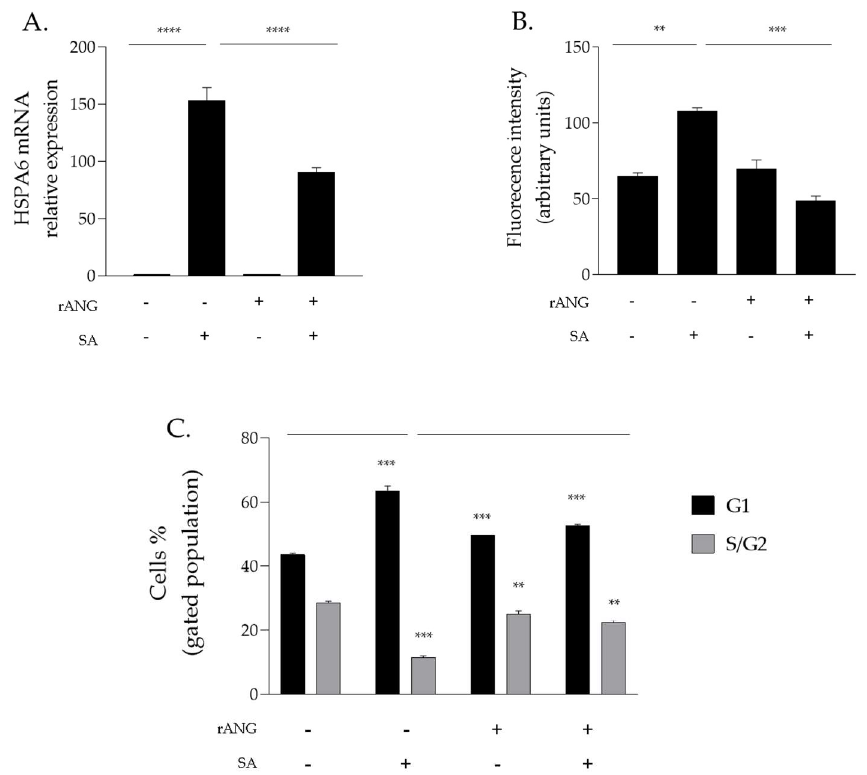
Figure 7. rANG effects on stress response of HaCaT cells. ( A ) RT-qPCR analysis of the expression of HSPA6 gene; ( B ) intracellular ROS detection by DCFH-Da assay; ( C ) distribution of HaCaT cells population among cell cycle G1 phase and S/G2 phase. (−) untreated cells; (+) pre-treatment of cells with 2 µ M rANG or 500 µ M SA. Values are the means ± SEM of biological replicates (** p < 0.01, *** p < 0.001, **** p < 0.0001) compared to the respective controls (one-way ANOVA, followed by Bonferroni’s post-test).